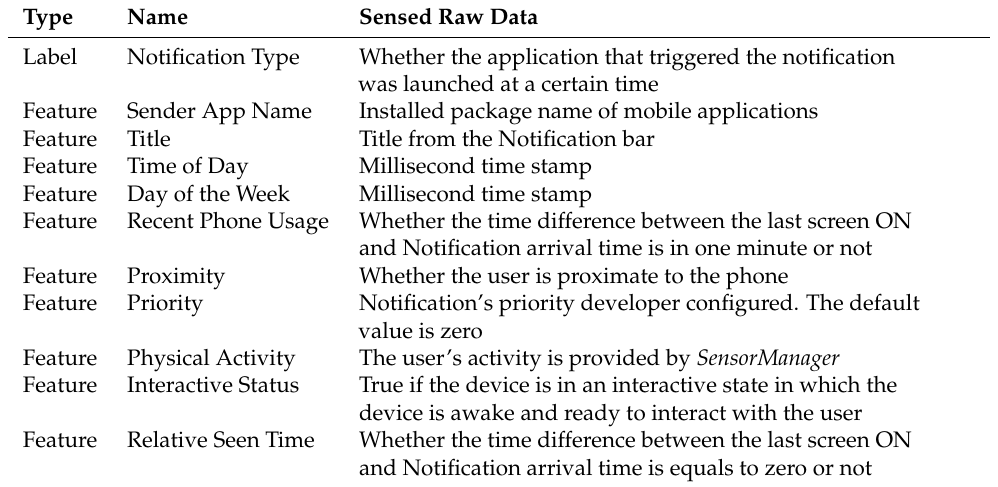
Table 2. Collected notification label and context features.